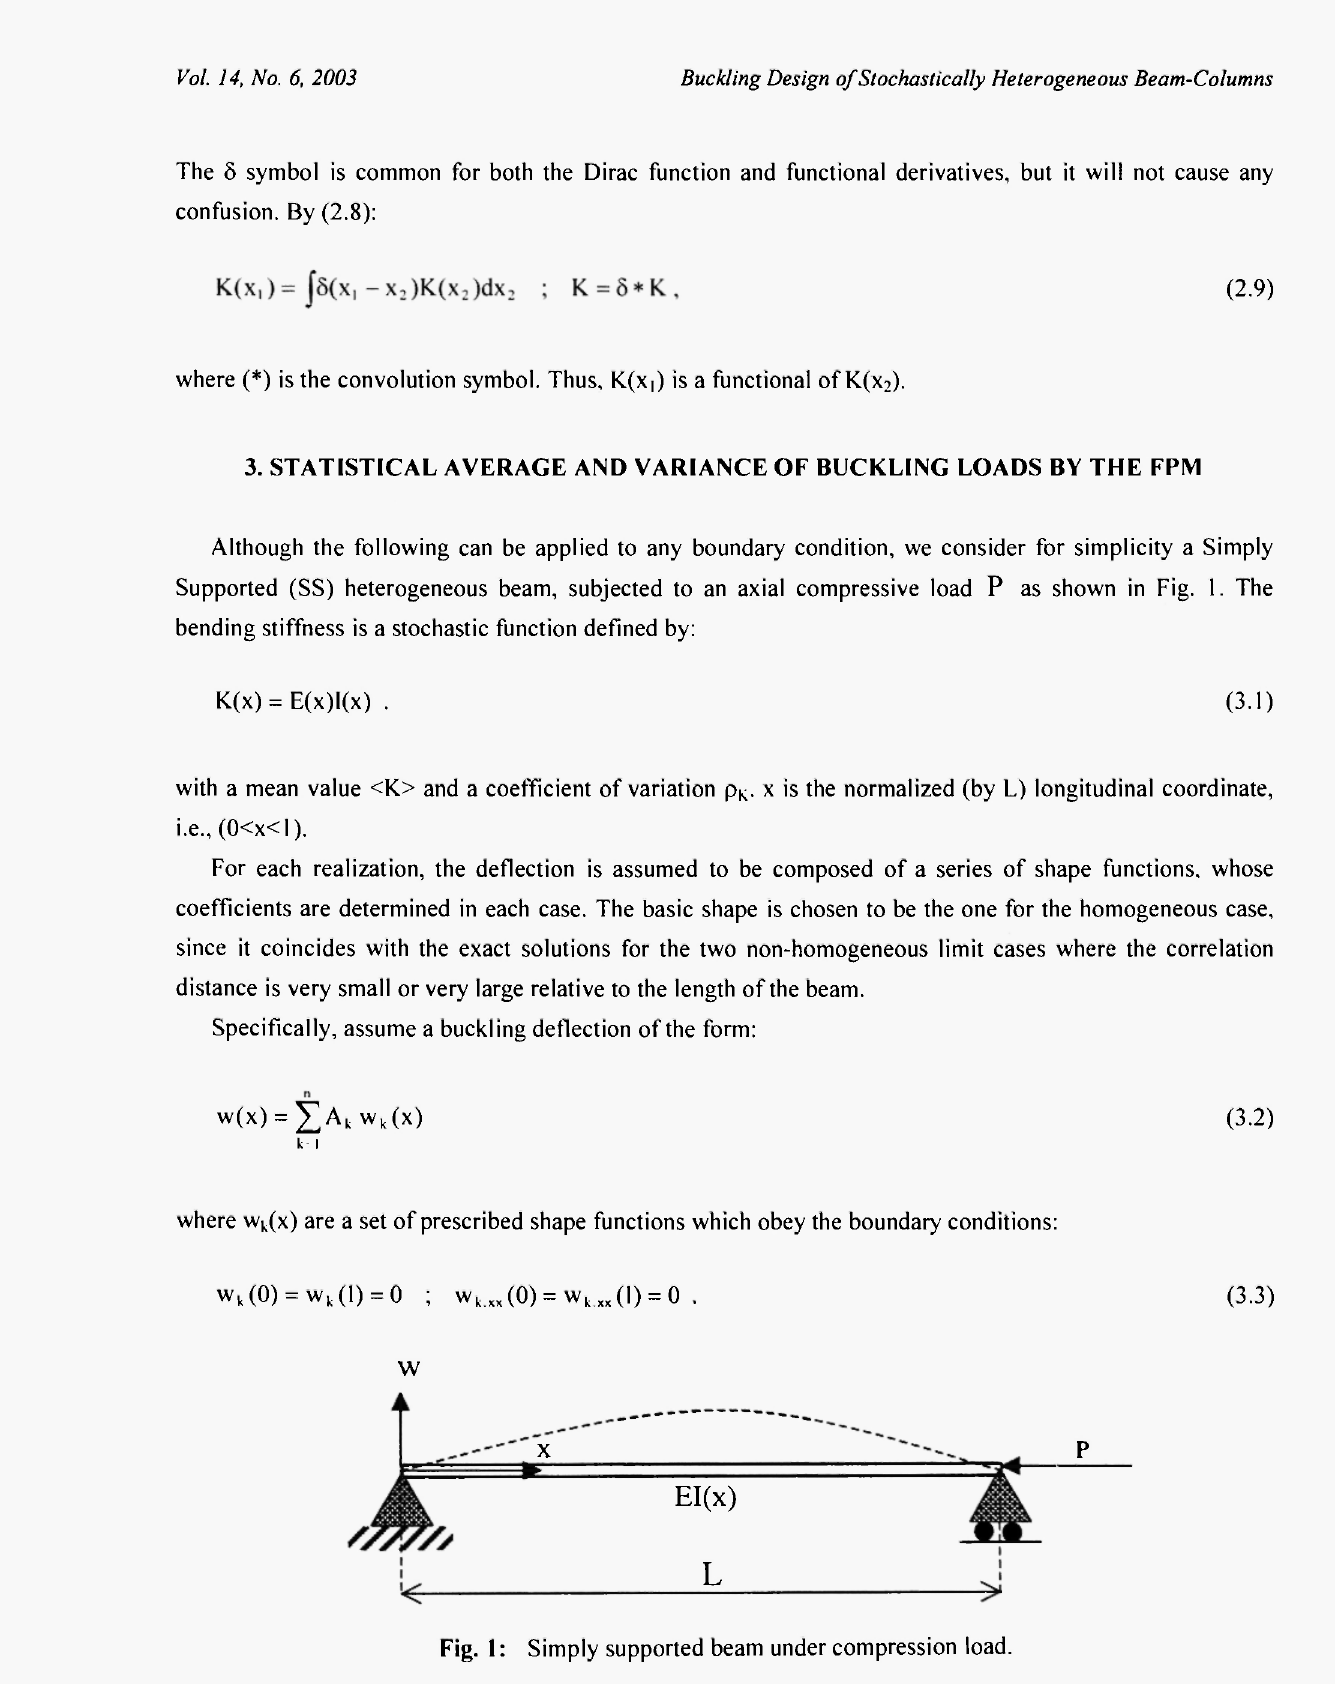
Fig. 1 : Simply supported beam under compression